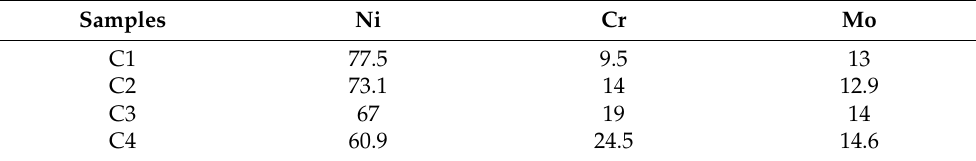
Table 2. Element content on the surface of Ni–xCr–Mo coatings in mass fraction (wt.%).